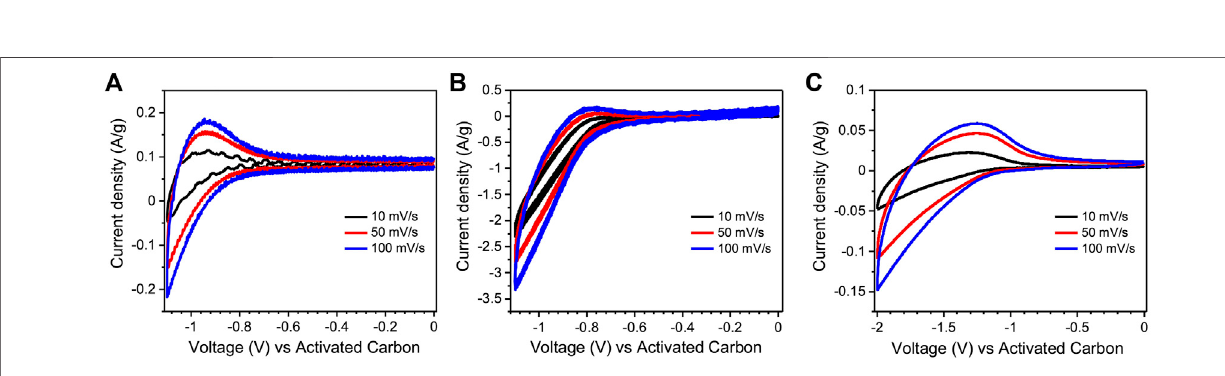
Frontiers in Electronics |